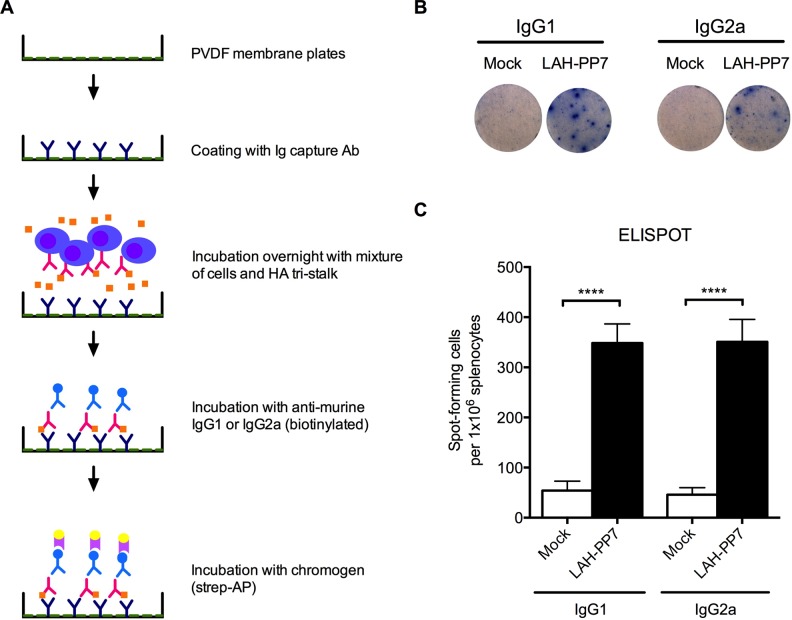
Detection of HA tri-stalk specific memory B cells.(A) ELISPOT assay workflow. (B) Representative pictures of spot-forming IgG1- or IgG2a-secreting cells in mice injected with PBS (mock) or LAH-PP7 fusion protein. (C) Comparison of total IgG1- and IgG2a-secreting B cells under stimulation by HA tri-stalk protein in the spleen of mice from mock and LAH-PP7 vaccinated groups (n = 8 mice/group; [29], ****p<0.00001).